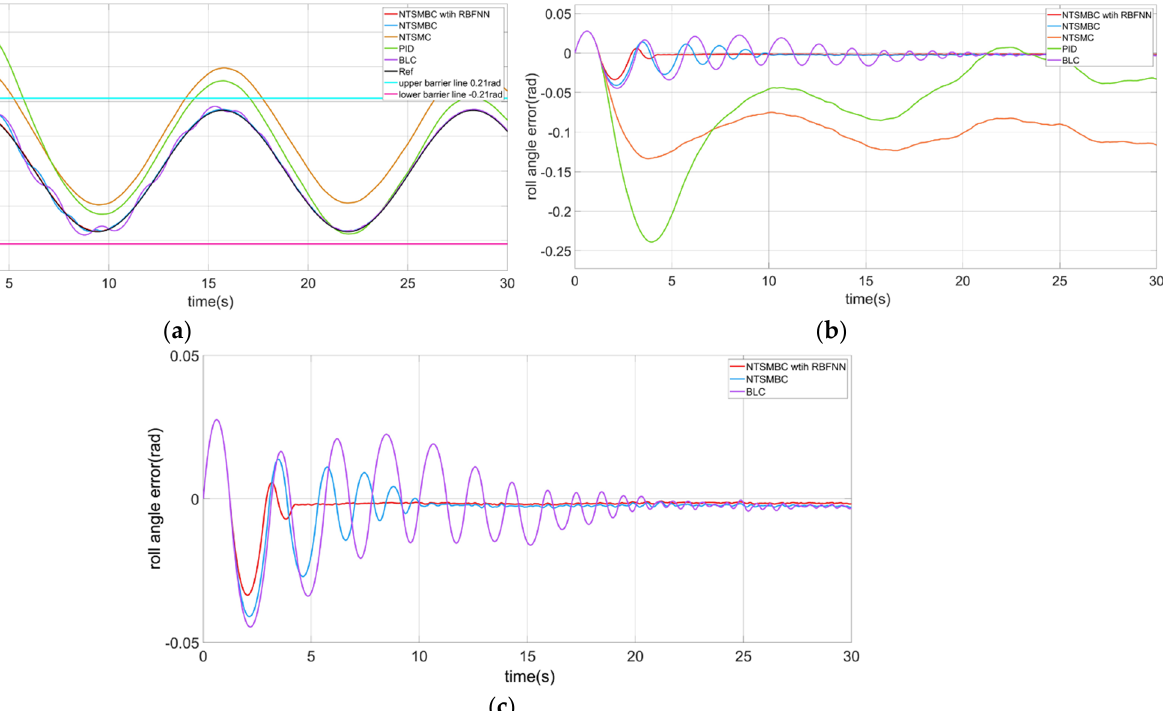
Figure 8. The roll angle control in the presence of the random lumped disturbance. ( a ) The roll angle control results of the four control methods with random lumped disturbance. ( b ) The roll angle control errors with the random lumped disturbance. ( c ) Local magnification.